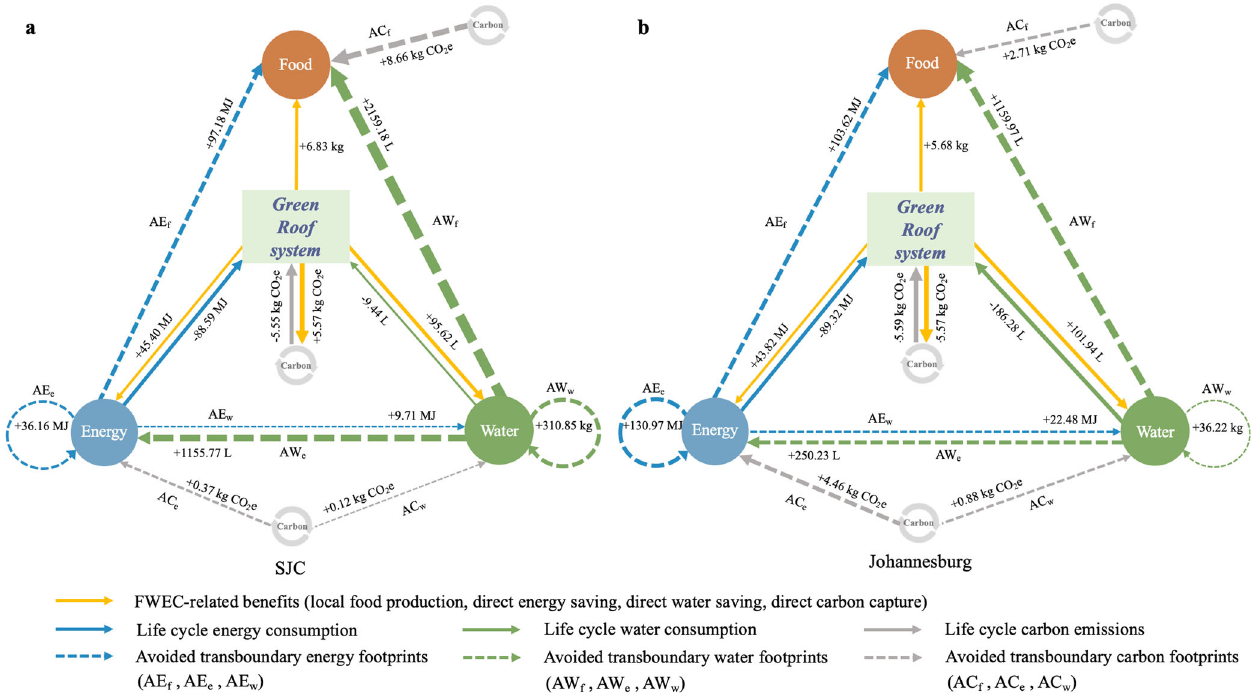
Fig. 2 Trade-offs of green roofs per square meter in relation to FWE nexus. The fi gure shows the life cycle environmental impacts, FWEC- related bene fi ts, and avoided transboundary environmental footprints of green roofs. Panels ( a ) and ( b ) illustrate the detailed results of green roofs ’ trade-offs in SJC and Johannesburg, respectively. The center rectangle in each panel represents the entire green roof system in this study, including green roof structures, open-air farming system, and rainwater harvesting system. Three colored circles represent the food, energy, and water sectors and the corresponding resources. Positive values are the bene fi ts of green roofs, in which the yellow arrows refer to the local direct FWEC-related bene fi ts, and the dashed arrows refer to the avoided transboundary environmental footprints, including avoided energy footprints (AE f , AE e , AE w ), avoided water footprints (AW f , AW e , AW w ), and avoided carbon footprints (AC f , AC e , AC w ). As for the subscript letters, f, e, and w refer to the local food production, direct energy saving, and direct water saving, respectively; AE f is the avoided transboundary energy footprints by local food production on green roofs, the same is true for the others (see Supplementary Table 1 for more abbreviations). Negative values represent the life cycle environmental burdens of green roofs, including energy consumption, carbon emissions, and water consumption over the green roofs ’ full life